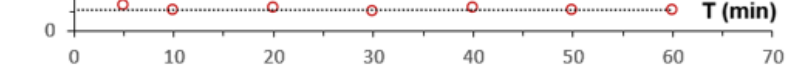
Figure 7. Changes in the permeate flux during the SAUF experiment. 3.1.2. Removal of Anionic Metal Species (TcO 4 − ) The radionuclide of the technetium-99 (Tc-99) is important from an environmental point of view because of its long half-life. It is usually produced in extremely small amounts as a result of the spontaneous fission of U-238, and it can be released into the environment in greater amounts by the nuclear fission of U-235, both as a result of nuclear reactor operation and military tests [27]. The amount of Tc-99 produced by the global nu- clear industry until 1983 was estimated to be at around 15,000 TBq (24 tons) [28].